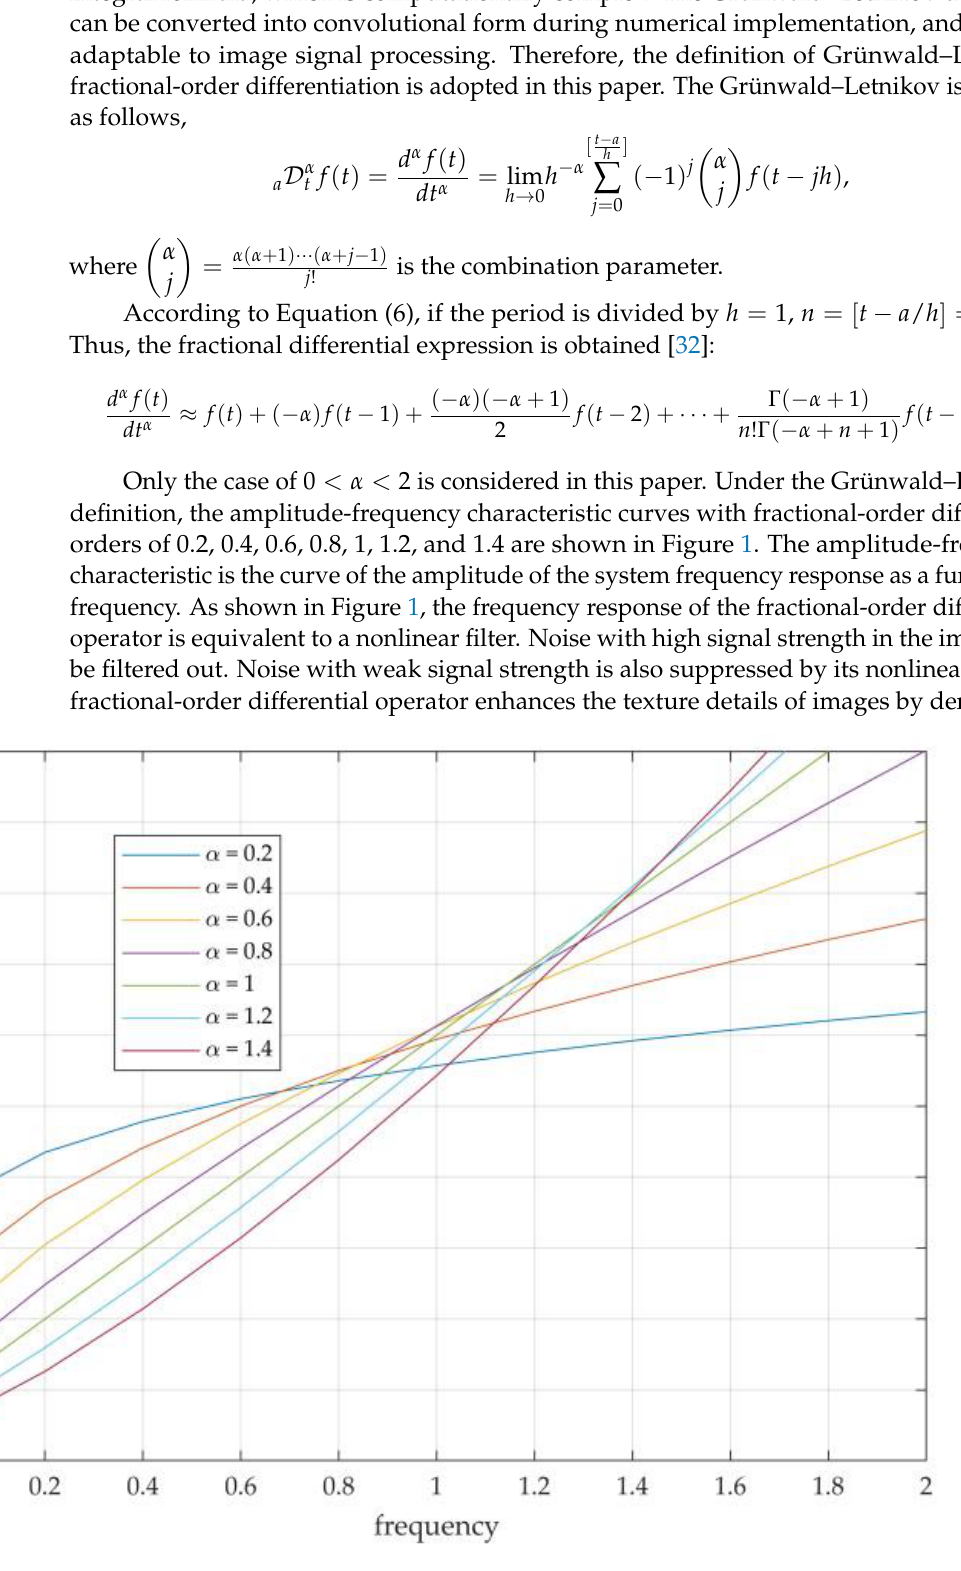
Figure 1. Fractional-order differential operator amplitude-frequency characteristic curve.